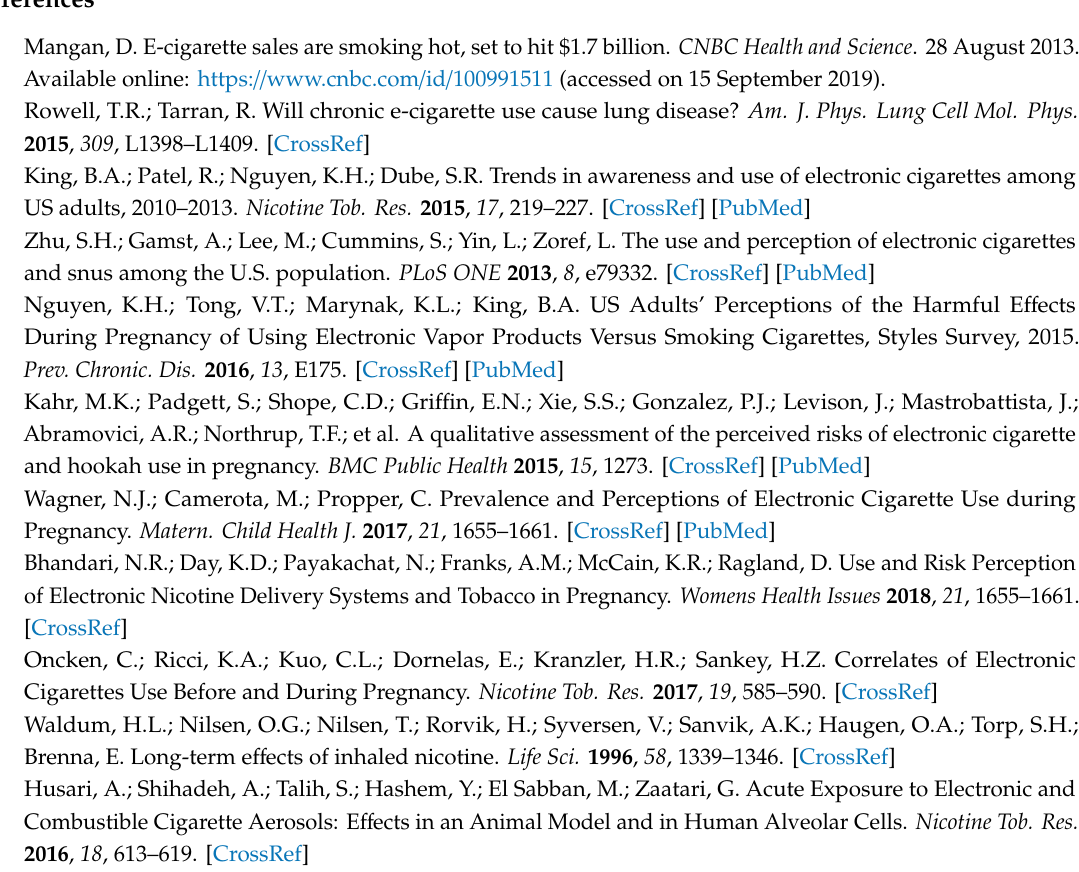
Table S1: Flavoring chemicals identified by non-targeted GCMS analysis. Flavoring chemicals present in the four refill solutions used in the study. M = menthol, S = strawberry, V = vanilla, T = tobacco. Author Contributions: The authors have made the following contributions to this publication: